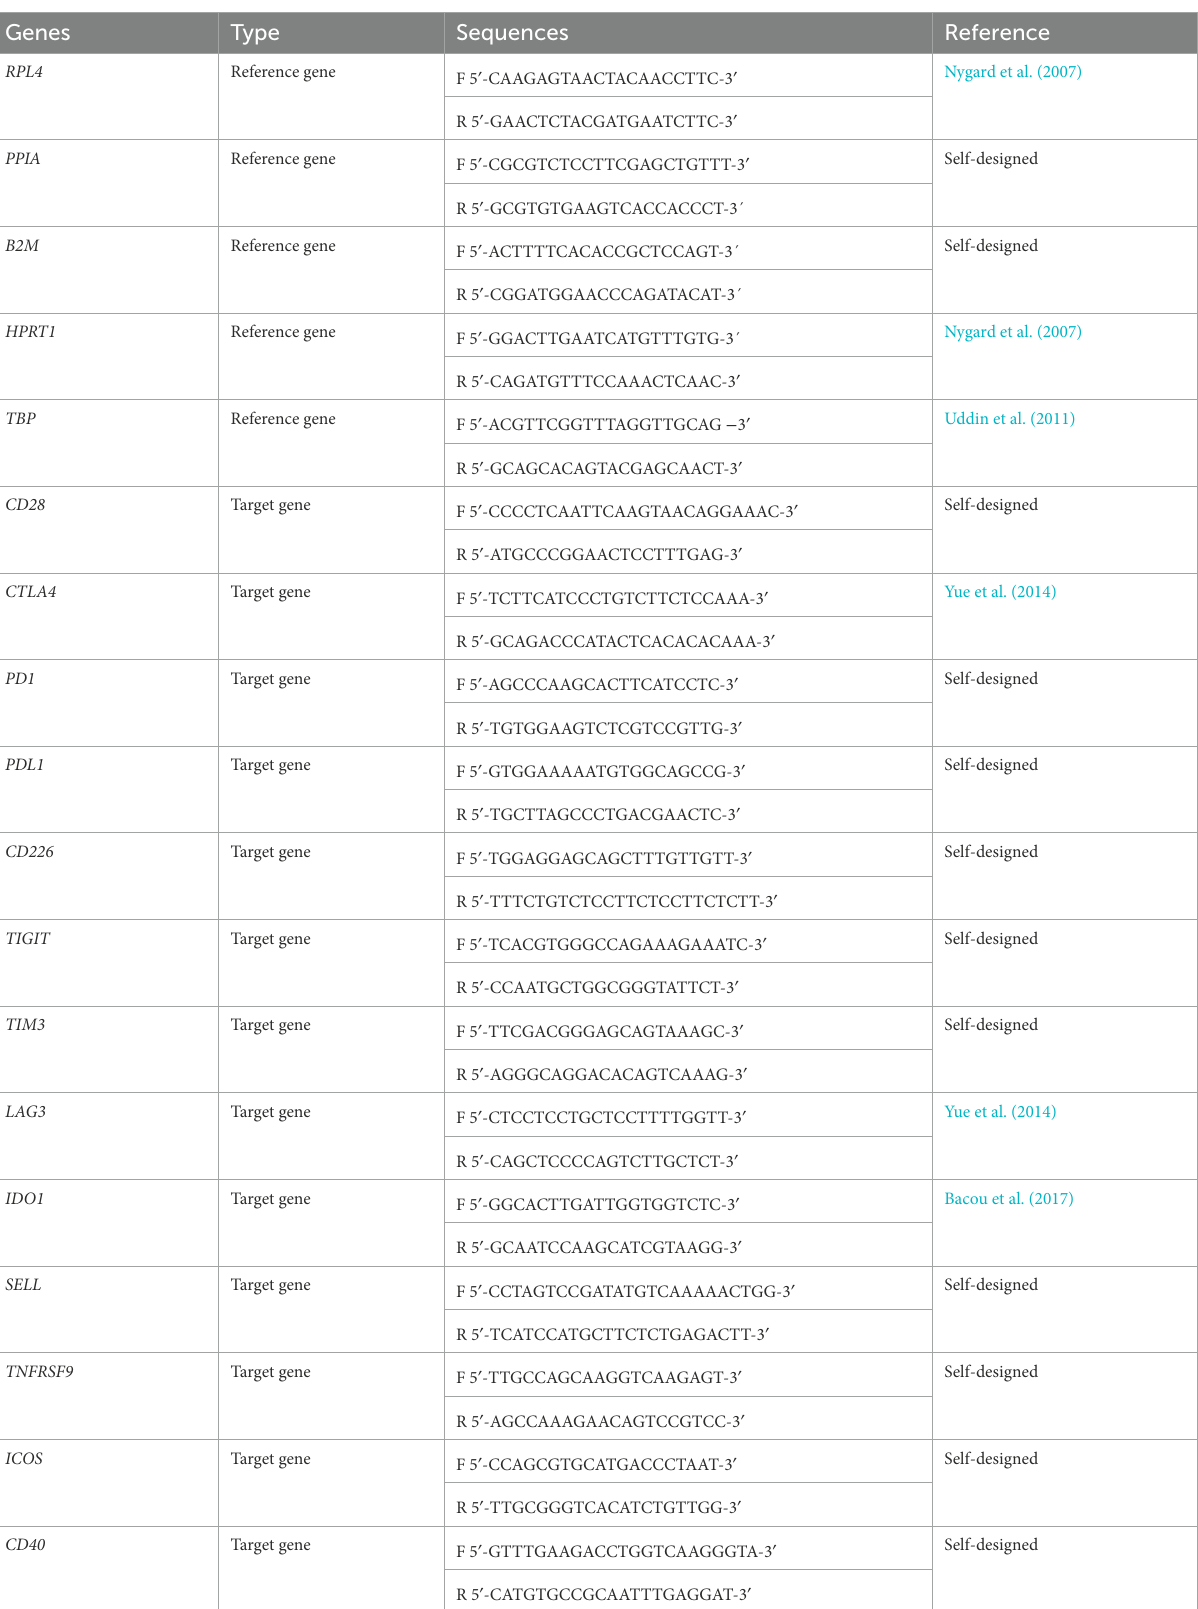
TABLE 1 Primer sequences of the porcine reference genes ( RPL4 , PPIA , B2M , HPRT1 , and TBP ) and target genes ( CD28 , CTLA4 , PD1 , PDL1 , CD226 , TIGIT , TIM3 , LAG3 , IDO1 , TNFRSF9 , SELL , ICOS , and CD40 ).